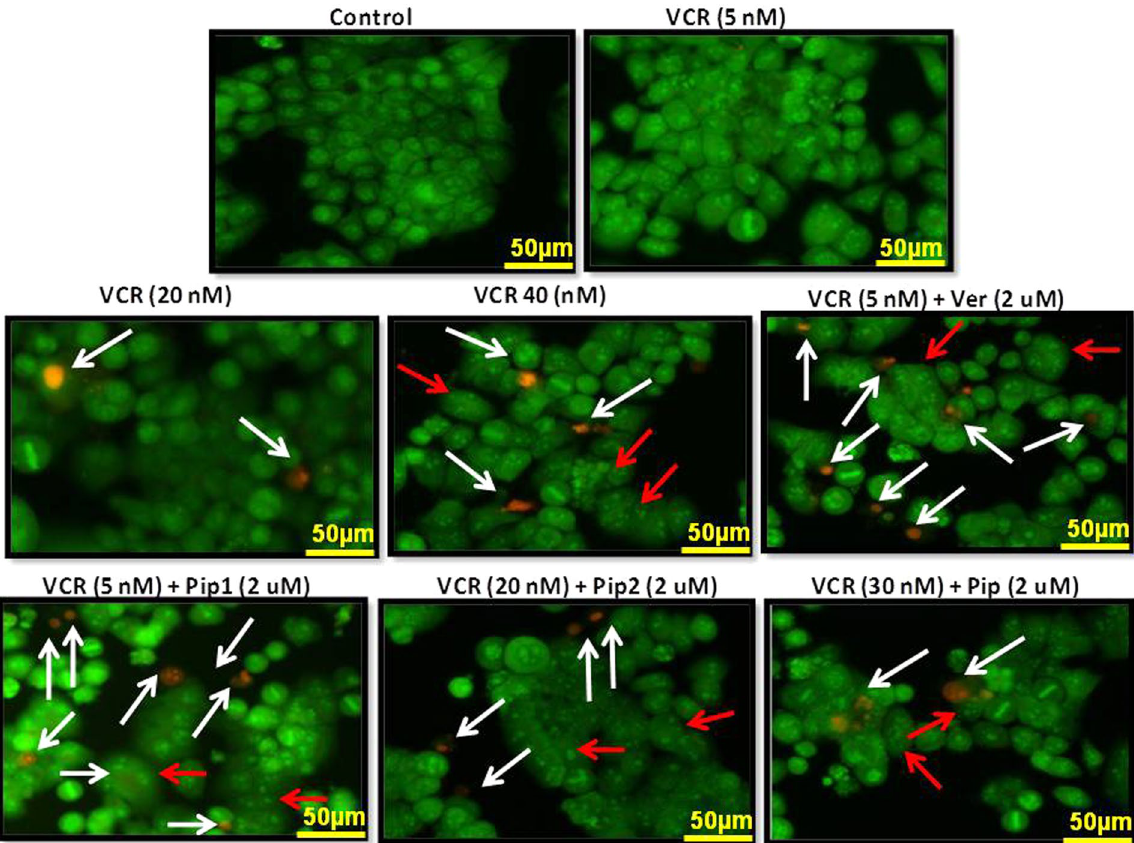
Figure 11. Evaluation of apoptosis incidence by acridine orange/ethidium bromide (AO/EB) dual staining. KB Ch R 8–5 cells were treated either with vincristine alone or combination of vincristine with piperine (Pip), verapamil (Ver), Pip1, or Pip2; control cells were treated with the culture media containing drug vehicle (DMSO). The apoptotic cells (orange to red fluorescence nuclei) are indicated by white arrows, whereas the red arrows indicate the nuclear fragmentation. All the images were acquired using 20 × objective in a Nikon Eclipse Ti-S inverted Fluorescence microscope (Nikon Instruments, Melville, New York) and the images were processed with Nikon Br 4.0